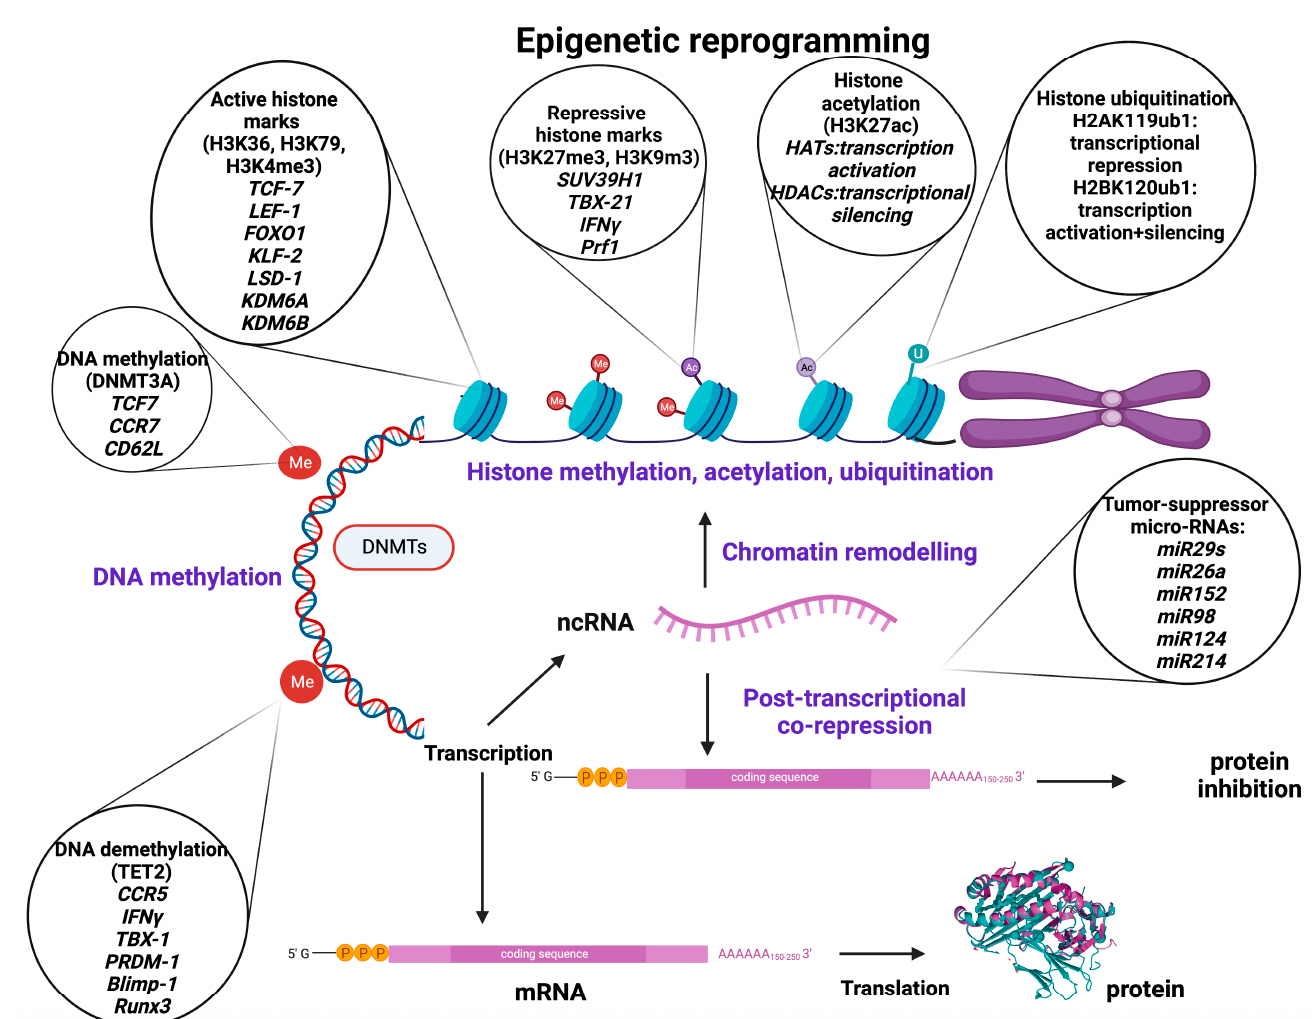
Figure 1. Basic epigenetic mechanisms, major epigenetic regulators, and target molecules involved in the regulation of genes related to T-cell stemness, memory, exhaustion, and trafficking as well as tumor immunity, development, and growth. Created with BioRender.com.